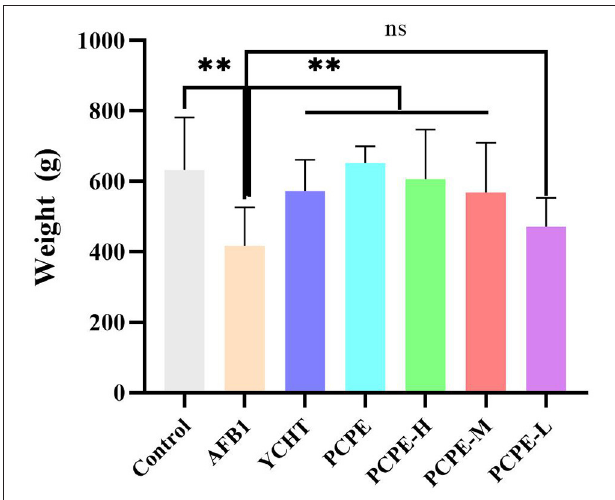
FIGURE 6 | Effect of PCPE on average final weight gain, growth performance of broilers whose feed diet contained AFB1 and PCPE low, medium, and high doses. The average weekly body weight of each group. ** P <